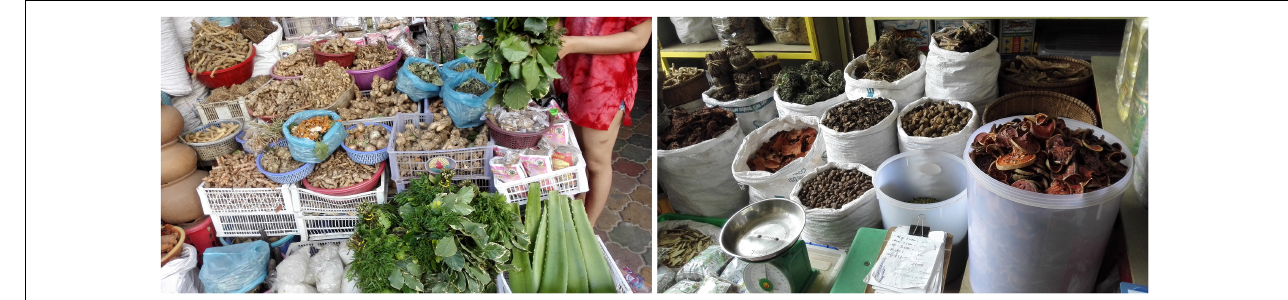
FIGURE 1 | Stalls in Orussey Market selling medicinal plants.